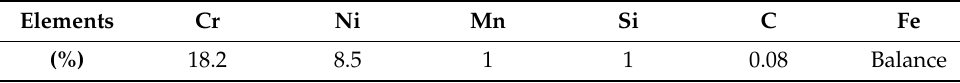
Table 1. Chemical composition of the